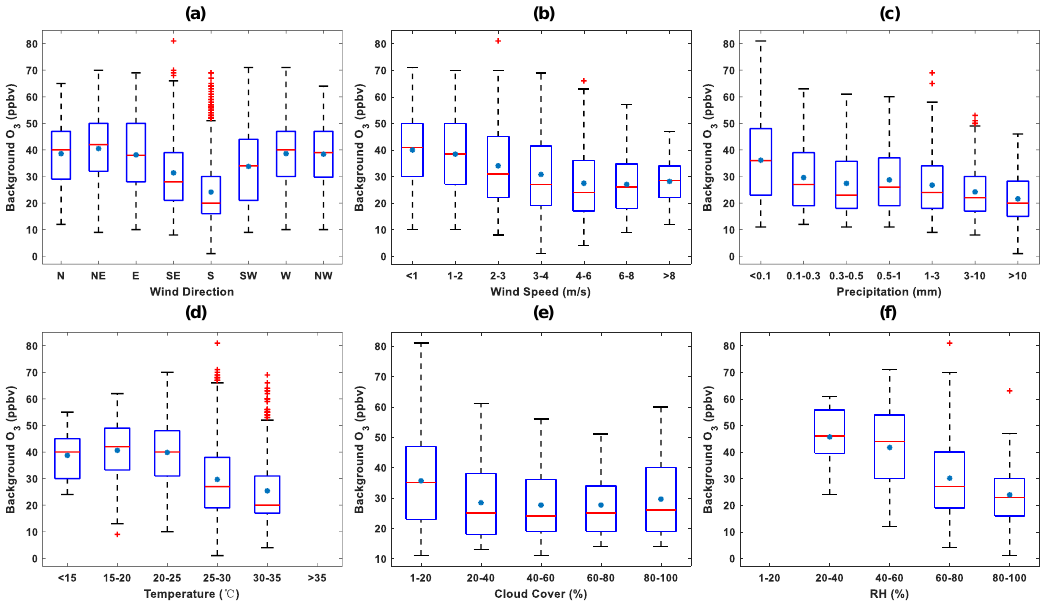
Figure 10. Box plots of background O 3 vs. ( a ) wind direction; ( b ) wind speed; ( c ) precipitation; ( d ) temperature; ( e ) cloud cover; ( f ) RH (blue “*” represents the means; red lines are the medians; red “+” marks are the